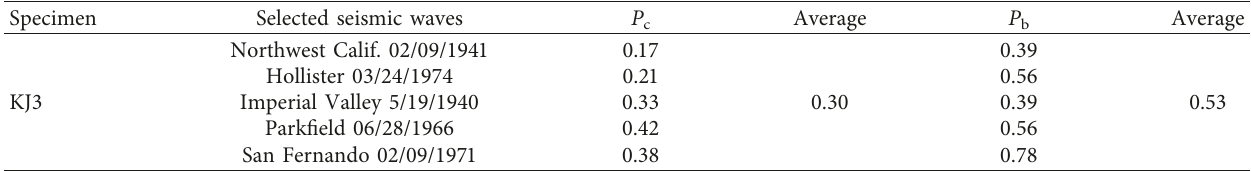
Table 8: Plastic hinge rates of beams and columns in model KJ3.